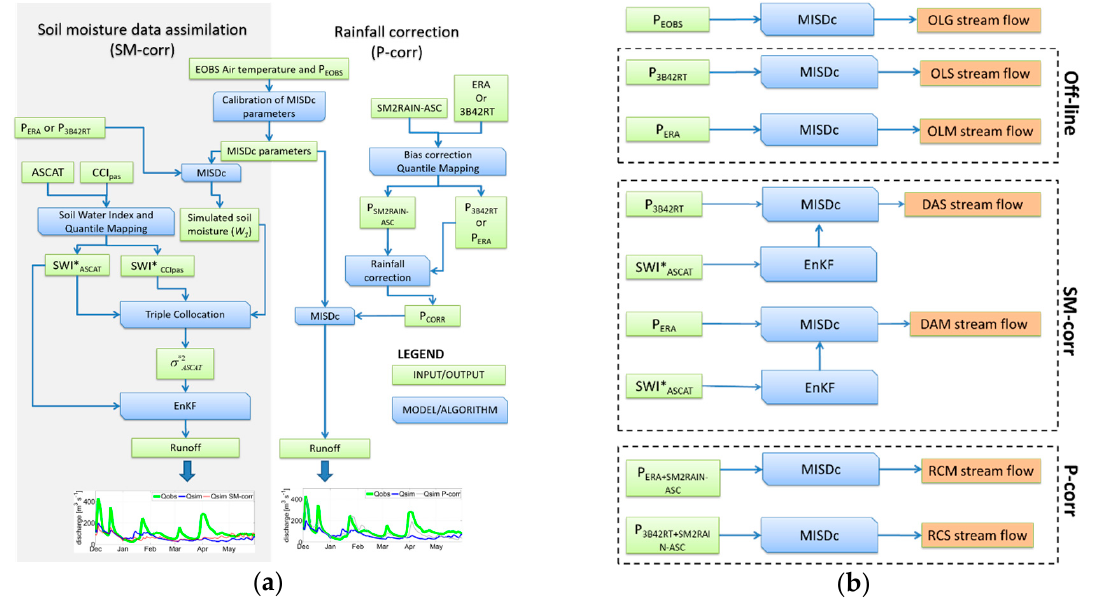
Figure 2. ( a ) Flowchart illustrating the main implementation steps of the soil moisture data assimilation (SM-corr, left) and the rainfall correction (P-corr, right) methods. ( b ) Simulation runs used in the study.